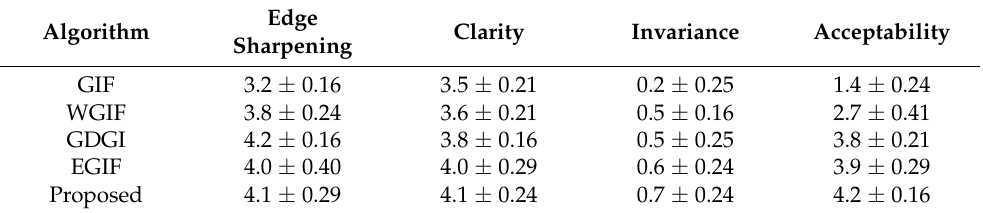
Table 5. Diagnostic quality assessment by different algorithms in Hamlin’s laparoscopic dataset (mean ± standard